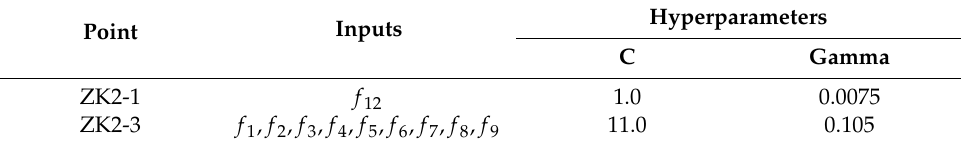
Table 7. Optimal hyperparameters and inputs of SVRs used for optimal weight